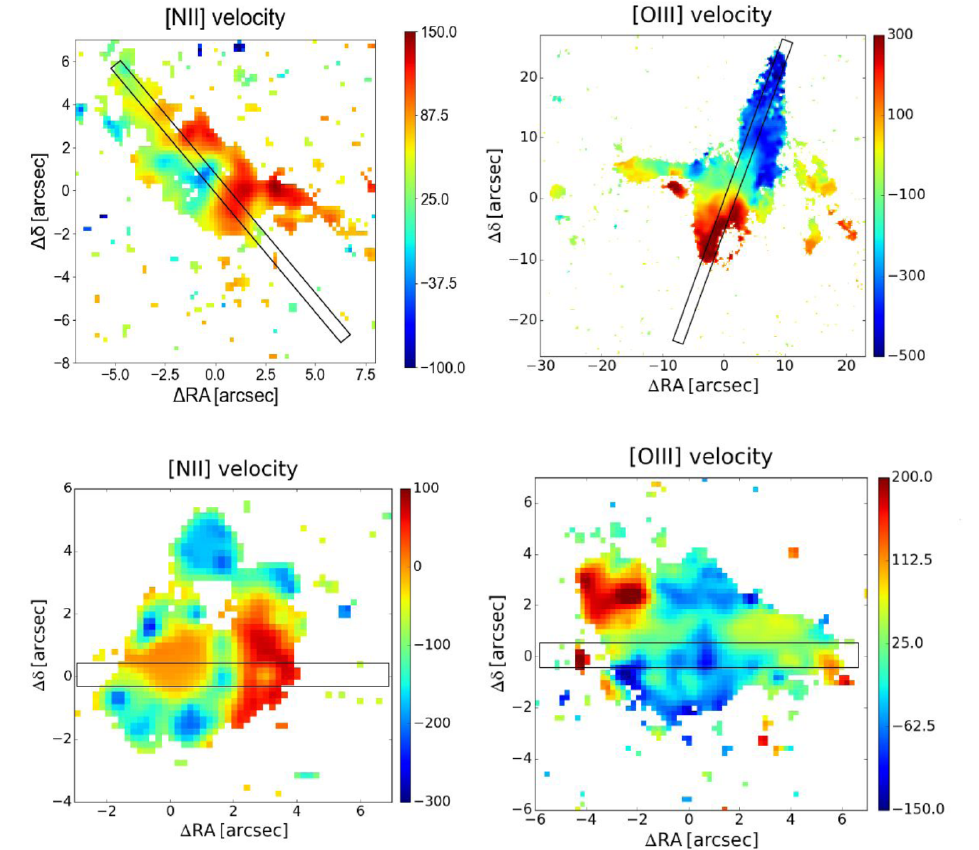
Figure 2. Velocity maps in the indicated emission-lines of the radio-loud AGNs 3C076, 3C079, 3C018 and 3C017 (clockwise from top left, [64,65]). Although some rotation seems to be present, disturbed kinematics dominate the velocity field of these galaxies, attributed to the interaction of the ambient gas with the radio jet. Velocity units are kms − 1